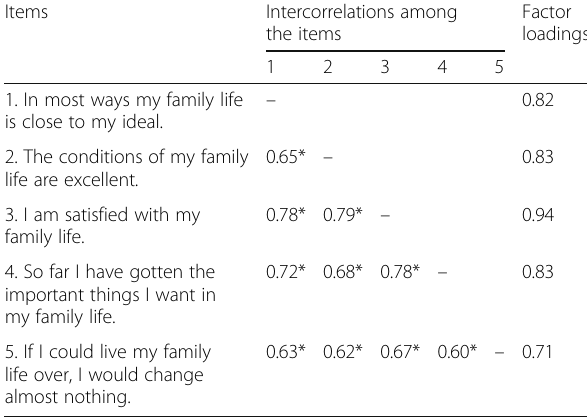
Table 1 Intercorrelations among the SWFLS items and factor